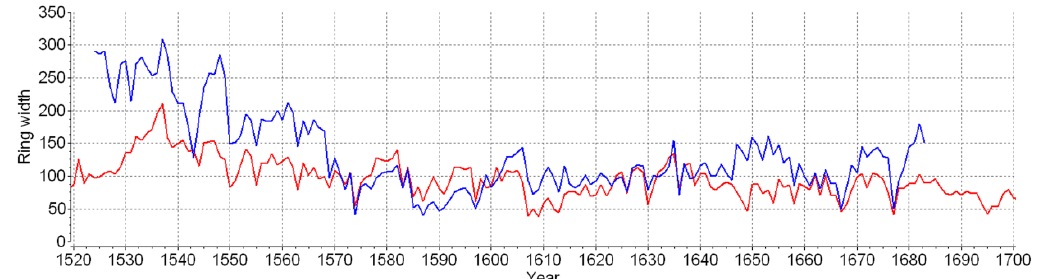
Figure 11. Visual cross-matching of the chronology representing timber from Gönpa Gang: UMGG_m (blue curve) with the Southern Mustang master chronology SM_Schmidt [30,31] in red. Only the overlapping period of the two chronologies is presented here. (TSAP-Win [48]).